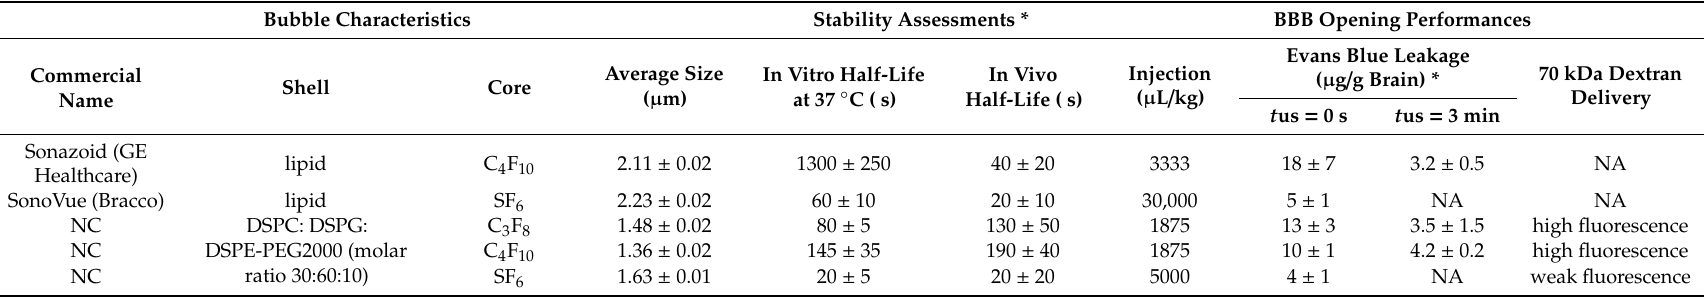
Table 4. Comparison of di ff erent bubbles on their stability and their abilities to open the BBB and deliver 70 kDa fluorescent dextran to the brain performed by Omata et al.